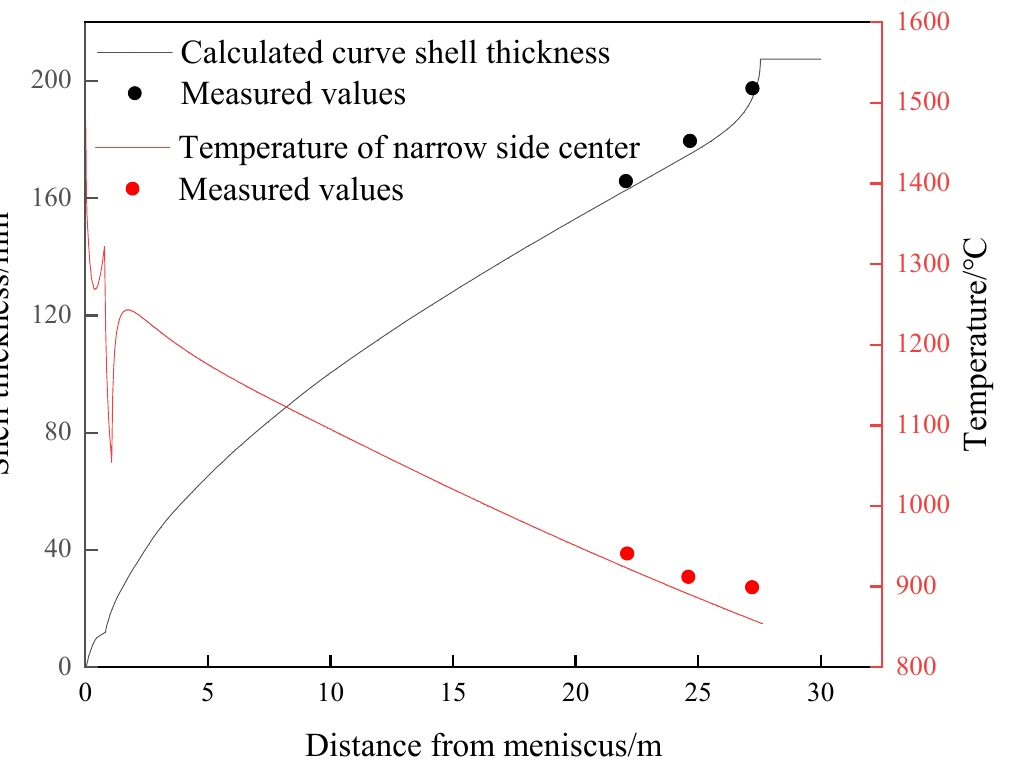
Figure 2. Comparison of the calculated temperature of the slab narrow side center.